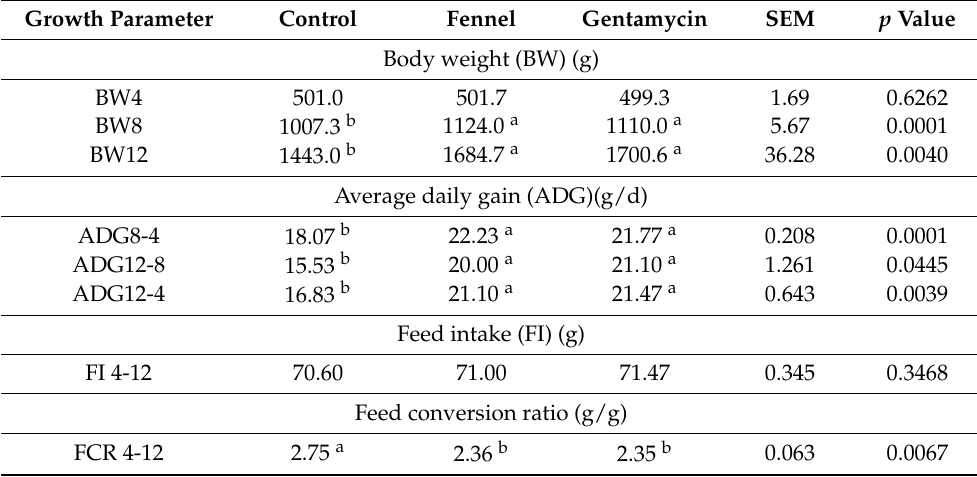
Table 3. Impact of dietary fennel oil or gentamycin on growth performance, feed intake, and feed conversion ratio of weaning Moshtohor rabbits aged 4–12 weeks.